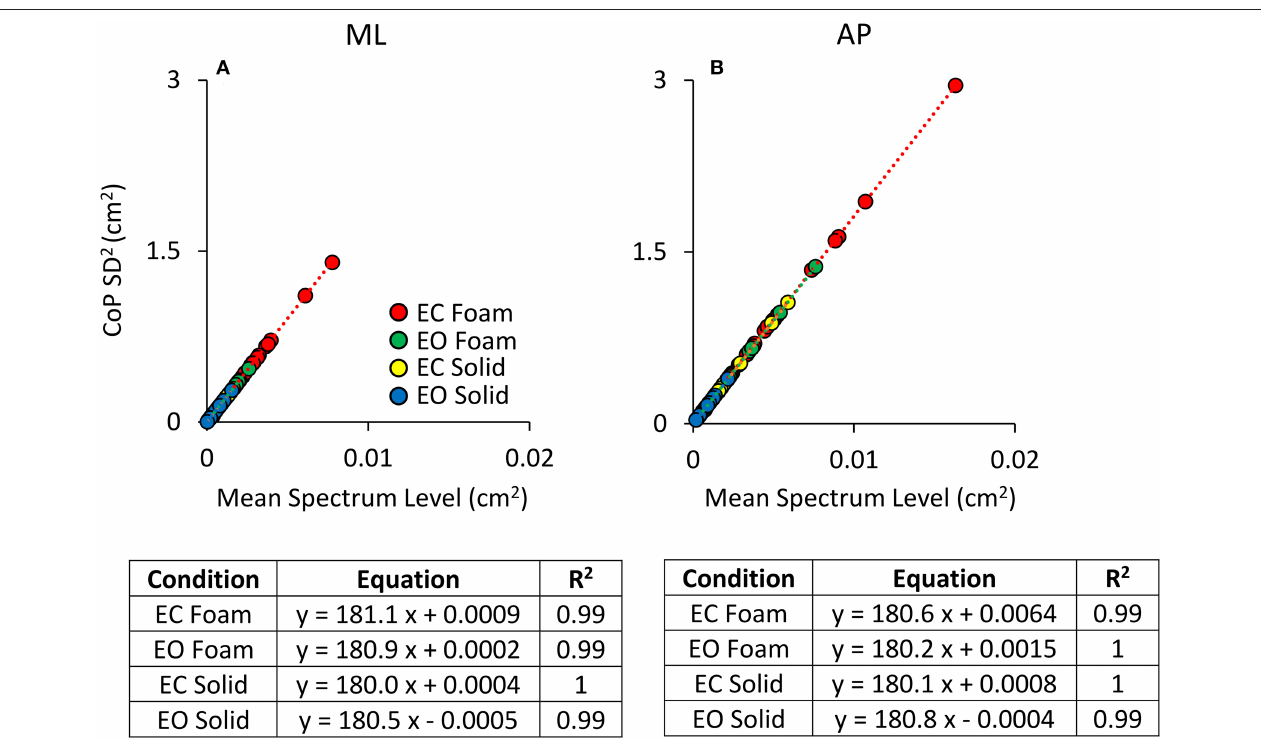
FIGURE 4 | Relationship between CoP variance (SD 2 ) and Spectrum Level. The values of the CoP SD 2 are plotted against the corresponding values of the mean Spectrum Level for both ML (A) and AP (B) directions and both visual and surface conditions (EC Foam, red; EC Solid, yellow; EO Foam, green; EO Solid, blue). Each dot corresponds to a subject. The slope of the lines best fitting the relationship between CoP SD 2 and mean Spectrum Level is identical between visual and support conditions and between ML and AP